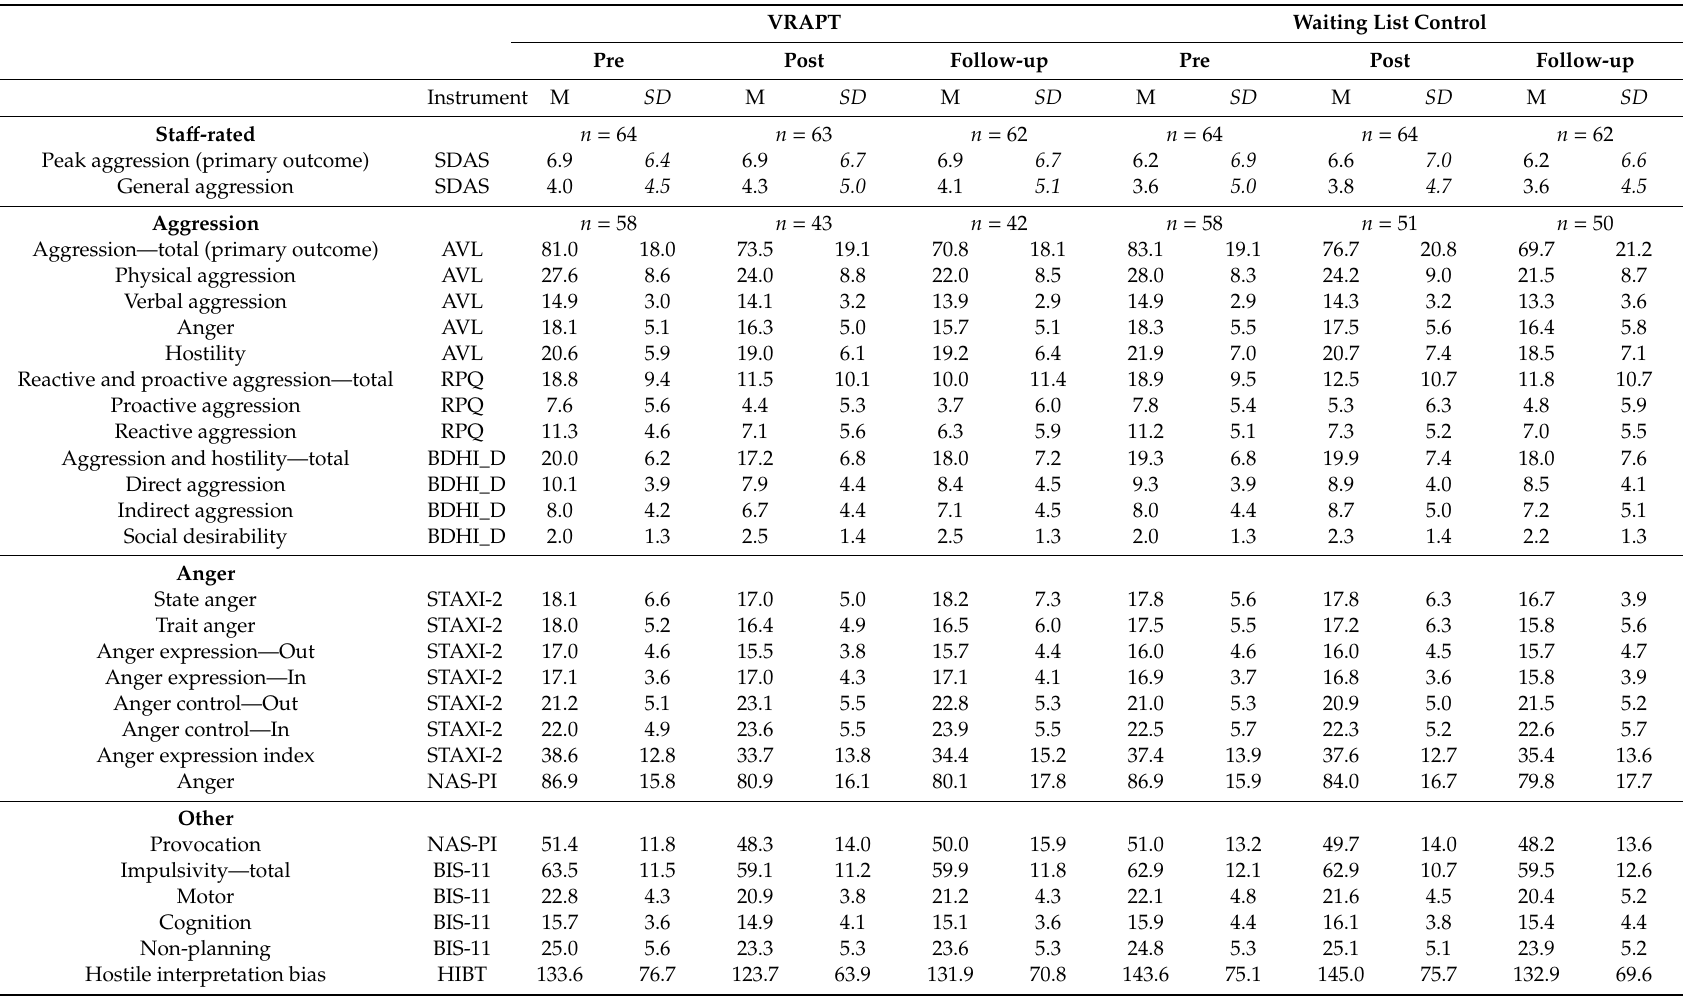
Table 2. Summary statistics of primary and secondary